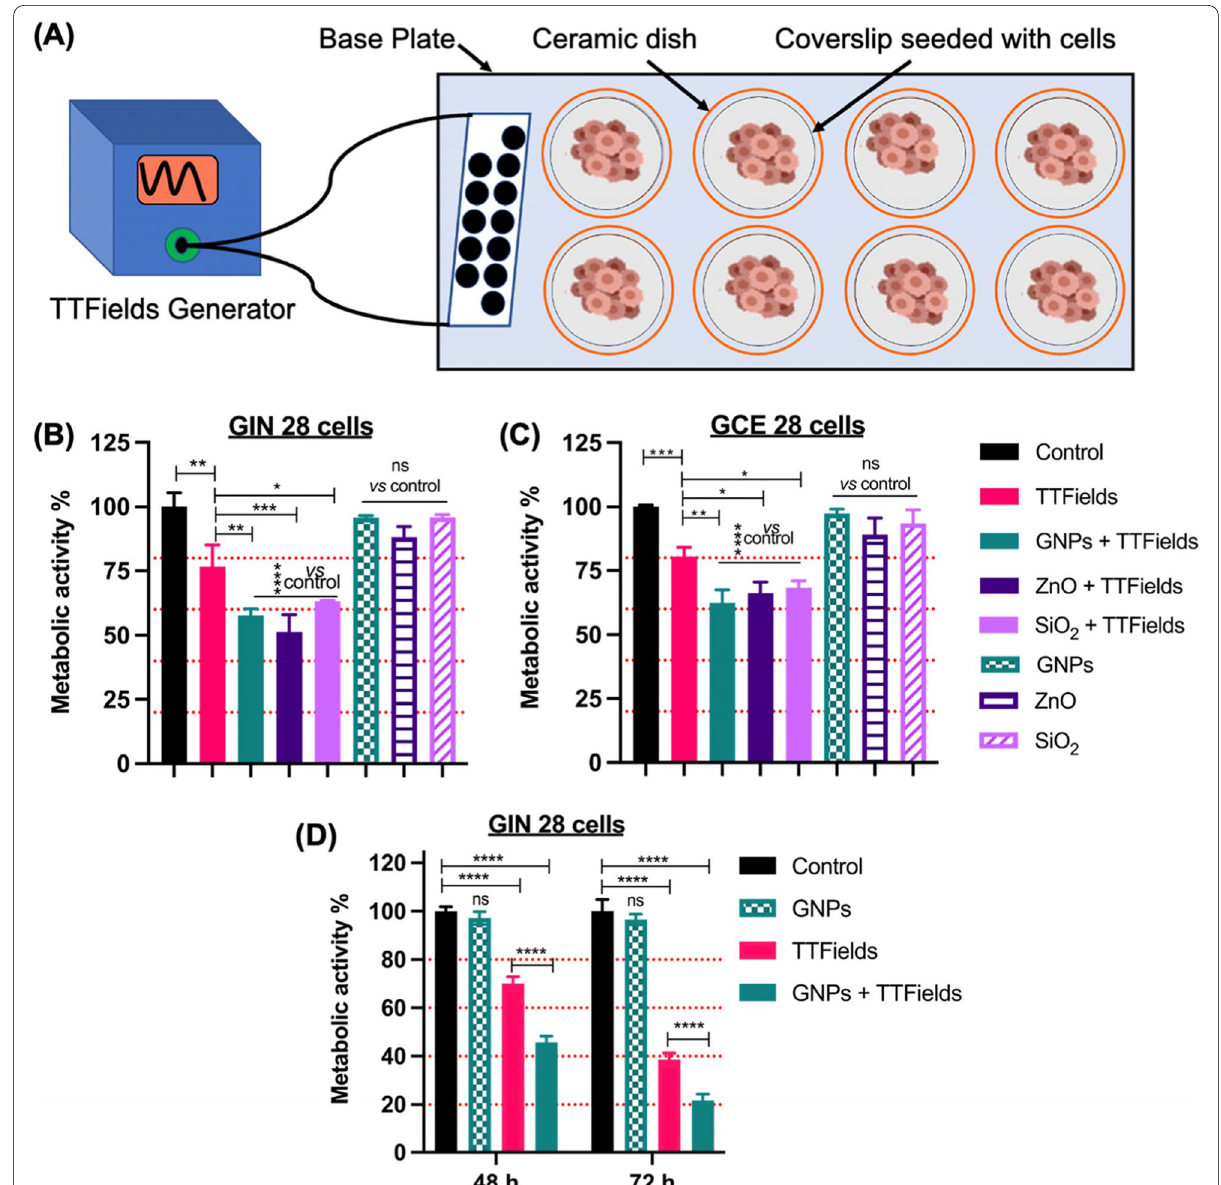
Fig. 3 TTFields and inorganic NPs (Gold – GNPs; Zinc oxide – ZnO; Silica oxide – SiO 2 ) mediated enhanced EF effects on patient-derived GBM cells. A Schematic representation of TTFields setup consisting of – a base plate containing 8 ceramic dishes is connected to TTFields generator via a flat cable. Cells were seeded on a coverslip placed within a ceramic dish. The base plate is placed inside an incubator where the cells were maintained at 37°C and 5% CO 2 . B GIN 28 cells and C GCE 28 cells were treated with TTFields at 300 kHz, 1V/cm, and 48 hours at NPs concentration of 5 μg/ mL. D GNPs mediated enhanced TTFields effect on GIN 28 cells at 300 kHz, 1V/cm after 48 and 72 hours at a concentration of 25 μg/mL. Error bar represents mean S.E.M. from triplicate or quadruplicate repeats and two independent ±